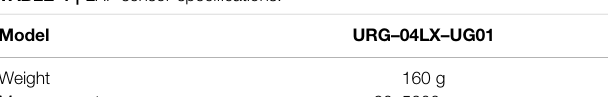
TABLE 4 | LRF sensor speci fi